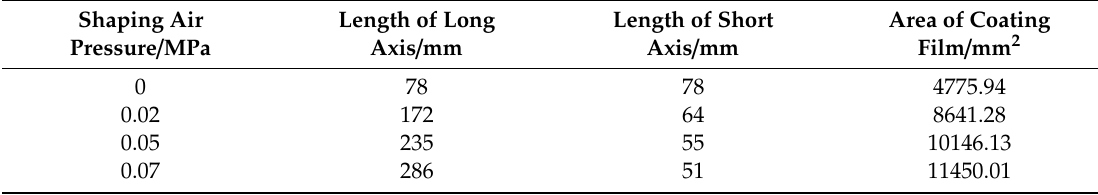
Table 3. Coating film thickness distribution for four shaping air